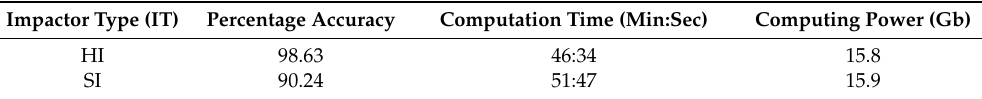
Table 1. Results of CNN on the individual HI and SI from the same height.